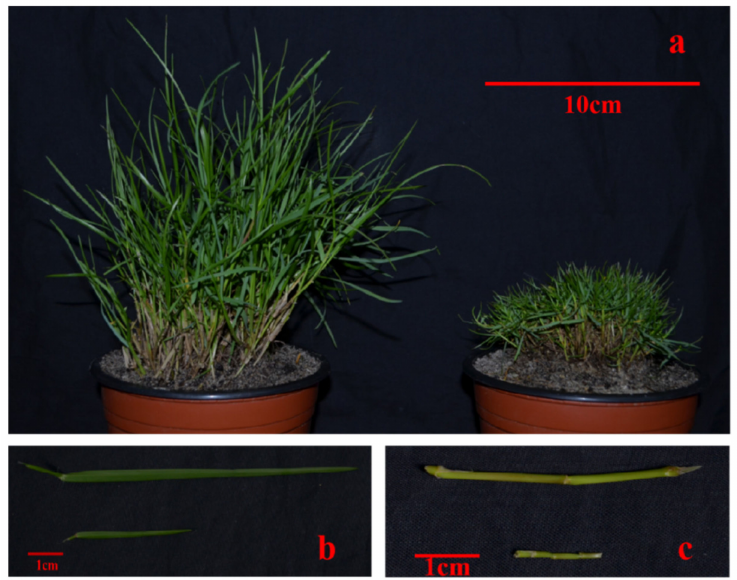
Figure 1. Phenotypic differences between WT and T51. ( a ) Plant types of WT and T51. ( b ) Leaves of WT and T51. ( c ) Erect stem of WT and T51. Table 1. Statistical analysis of morphological differences between WT and T51.